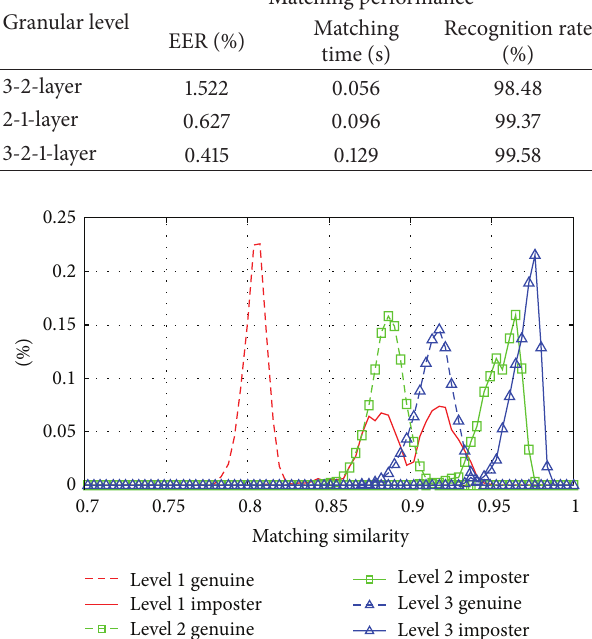
Figure8:Similaritydistributionsofgenuineandimpostermatching at three granularity levels.